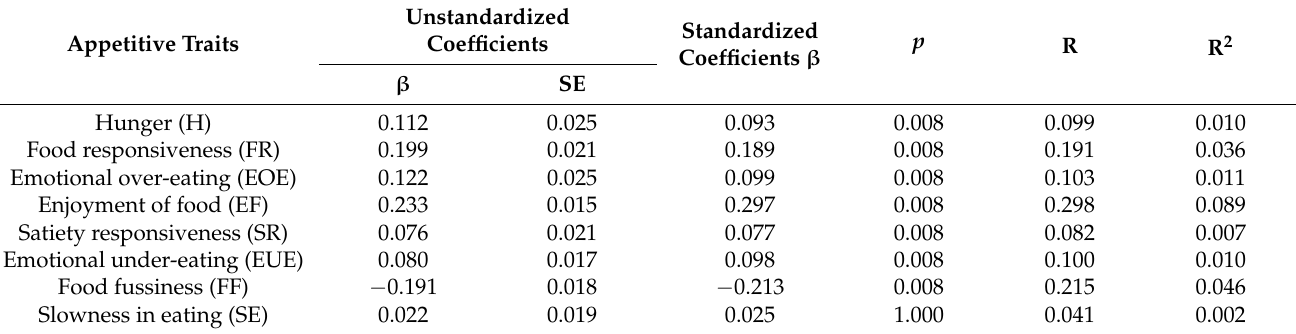
Table 10. Analysis of association between appetitive traits and starches preference assessed by Food Preference Ques- tionnaire (FPQ) (model adjusted for sex and age) within the population of the second phase of the Polish Adolescents’ COVID-19 Experience (PLACE-19) Study ( n =